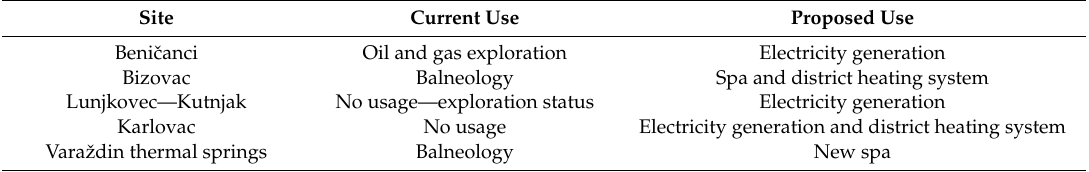
Table 5. Observed sites current and proposed